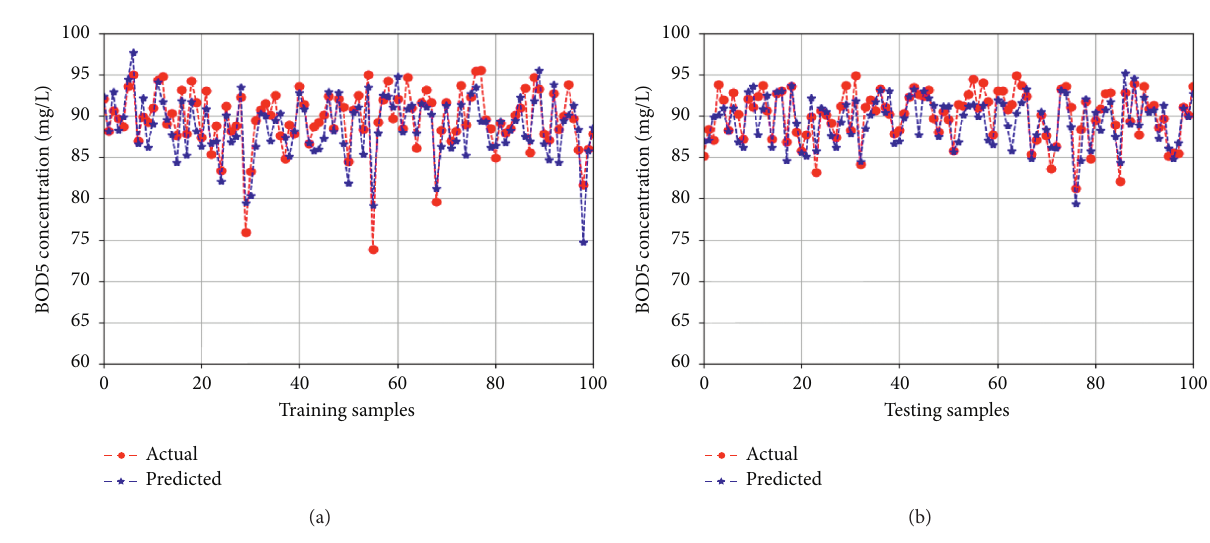
Figure 7: Soft sensor performance prediction based on SVR.